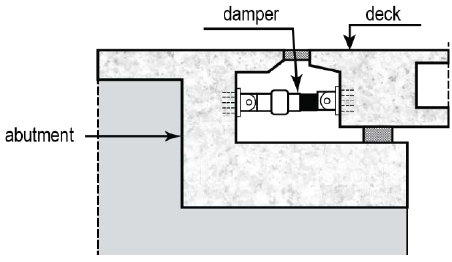
Figure 3. Typical nonlinear fluid viscous damper [24].